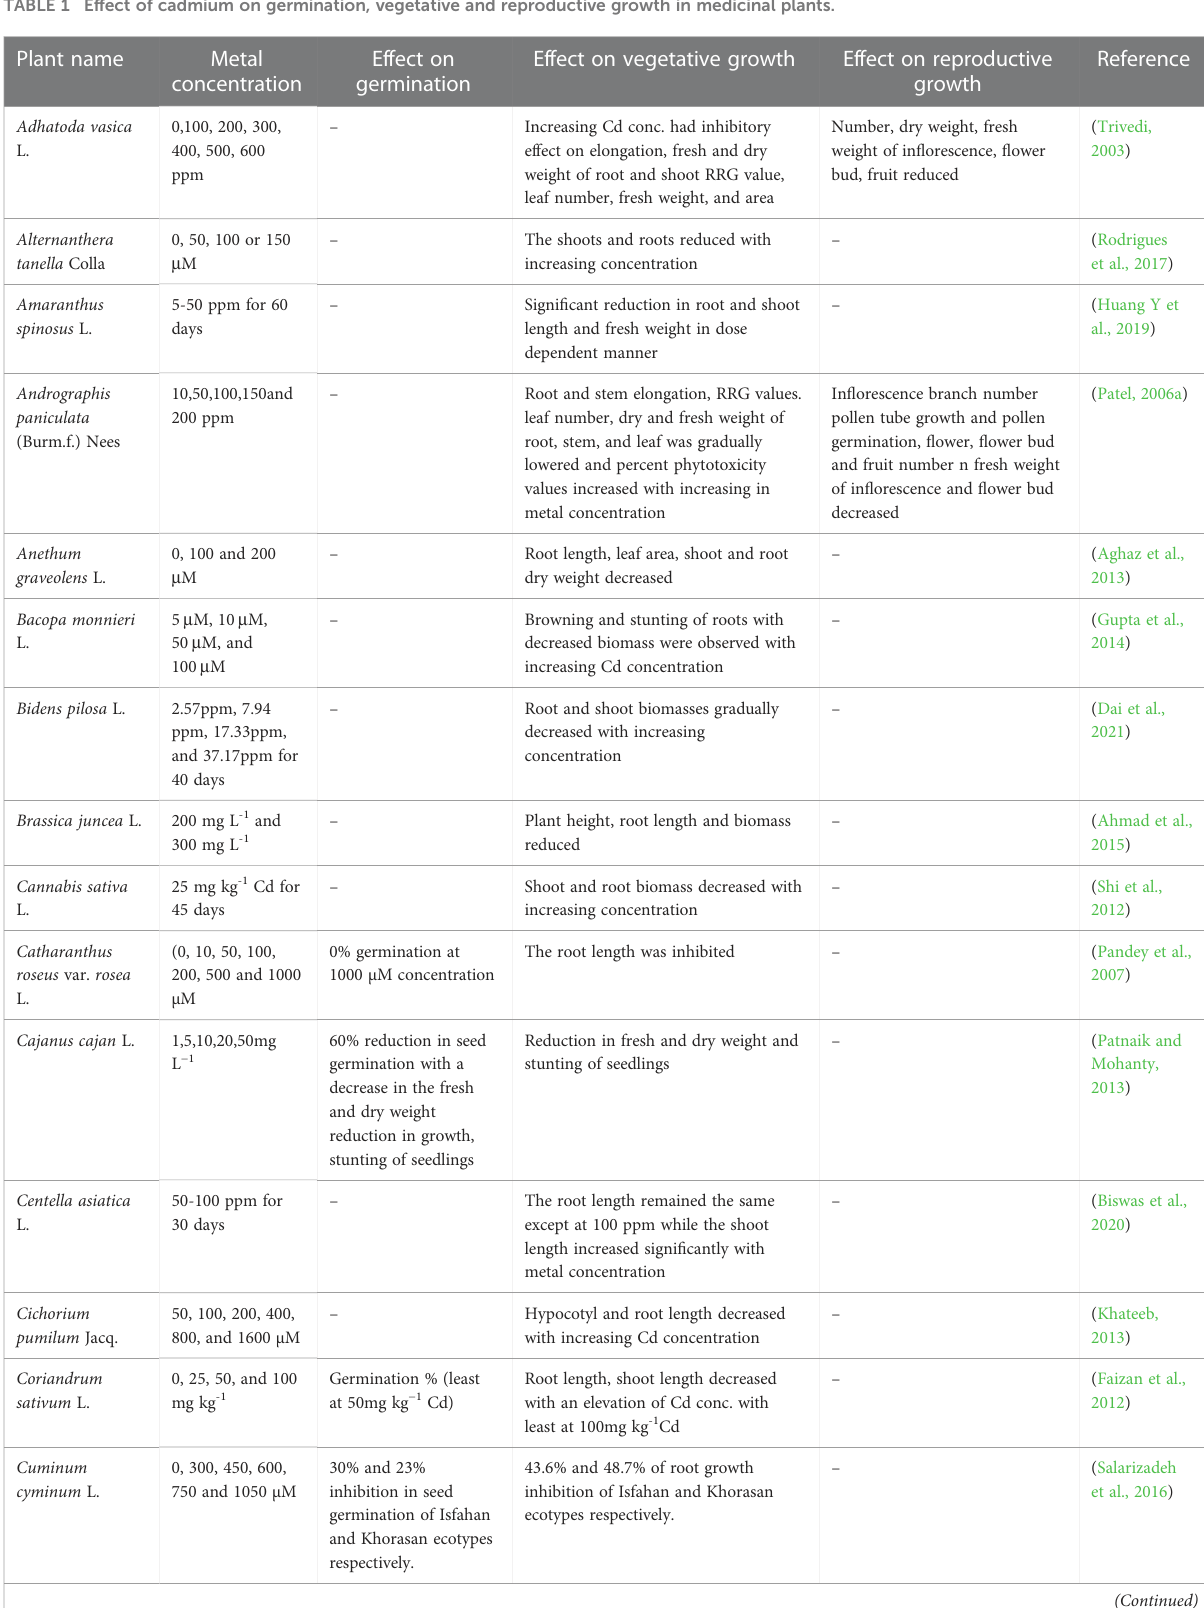
TABLE 1 Effect of cadmium on germination, vegetative and reproductive growth in medicinal